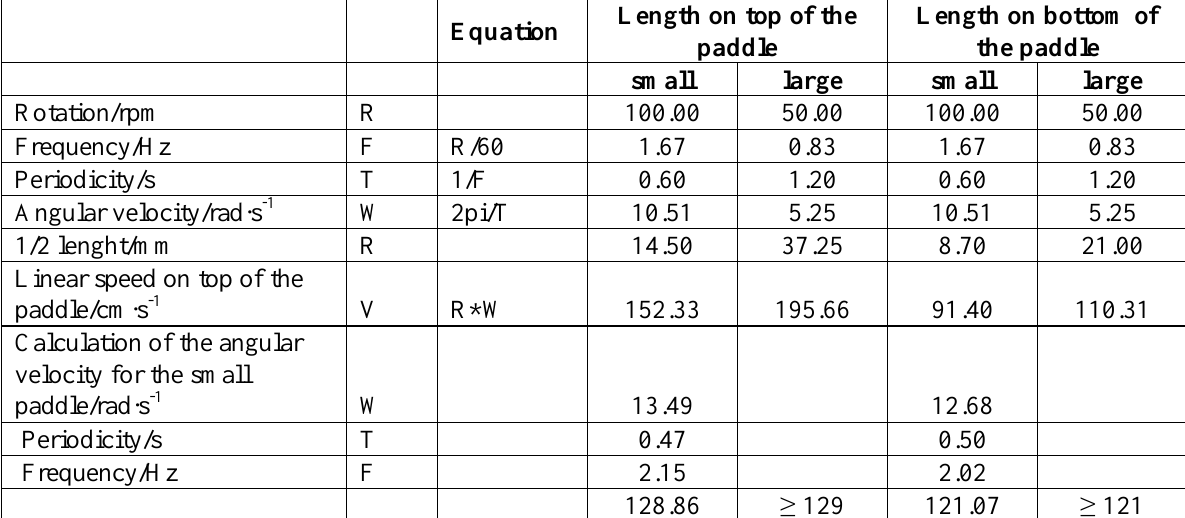
Table 5. Theoretical calculation of hydrodynamics difference between small paddle and large paddle. Length on top of the Length on bottom of Equation paddle the paddle small large small large Rotation/rpm R 100.00 50.00 100.00 50.00 Frequency/Hz F R/60 1.67 0.83 1.67 0.83 Periodicity/s T 1/F 0.60 1.20 0.60 1.20 Angular velocity/rad·s -1 W 2pi/T 5.25 1/2 lenght/mm 21.00 Linear speed on top of the paddle/cm·s -1 V R*W 152.33 195.66 91.40 110.31 Calculation of the angular velocity for the small paddle/rad·s -1 W 12.68 Periodicity/s T 0.47 Frequency/Hz F